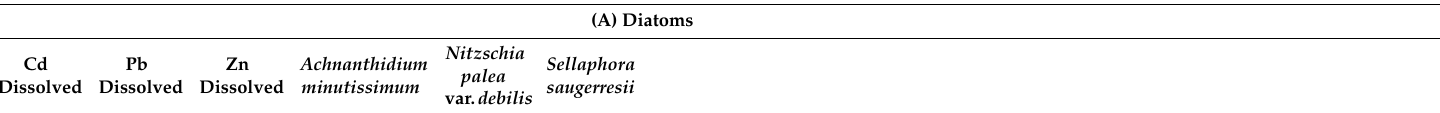
Table 7. Spearman’s rank order correlation for diatoms (A), cladocerans (B), and physicochemical parameters of water of subsidence ponds formed during the peak of ore exploitation